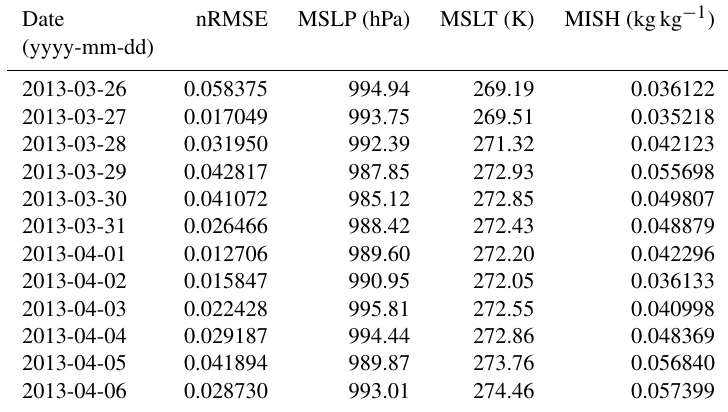
Table A2. Normalized root mean square error (nRMSE), mean surface level pressure (MSLP), mean surface level temperature (MSLT), and mean integrated specific humidity